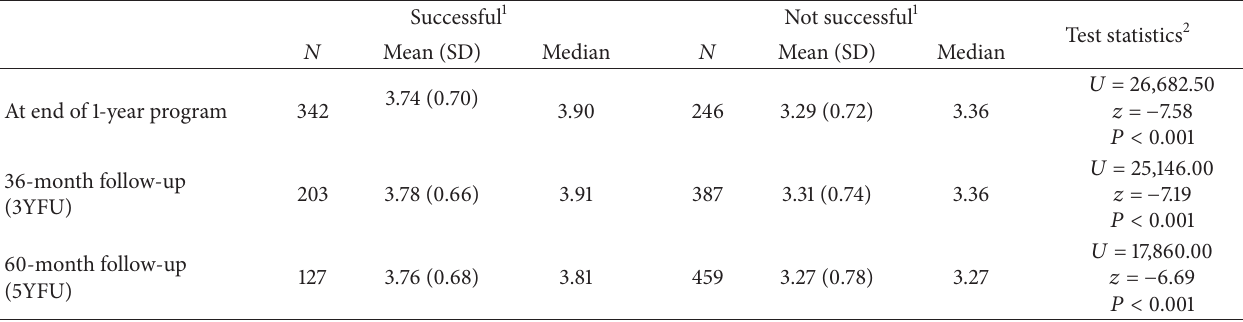
Table 7: Average scores on the overall quality of life at the end of the program and after 3 and 5 years after start of the program (score range: 0–5; the higher the score the higher quality of